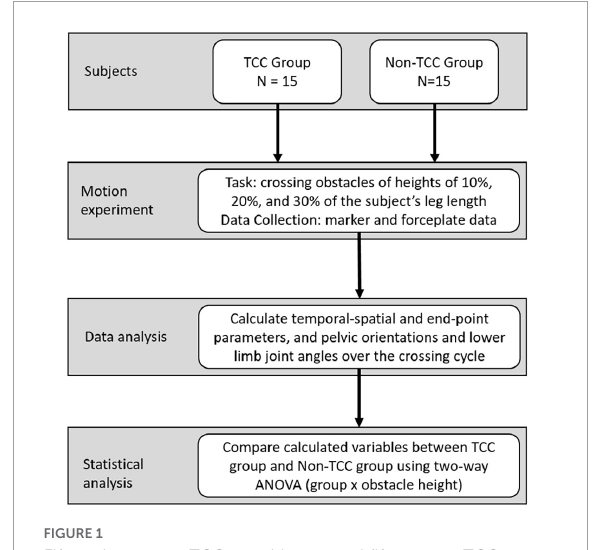
FIGURE1 Fifteen long-term TCC practitioners and fifteen non-TCC practitioners were recruited for this study. All the practitioners were requested to cross the obstacles at three different heights during walking. At the same time, the three-dimensional motions of the pelvis and lower extremities were measured using a motion capture system. After data collection, joint angles of lower extremities and pelvic kinematics were calculated, and the data from the TCC group and Control group were compared.